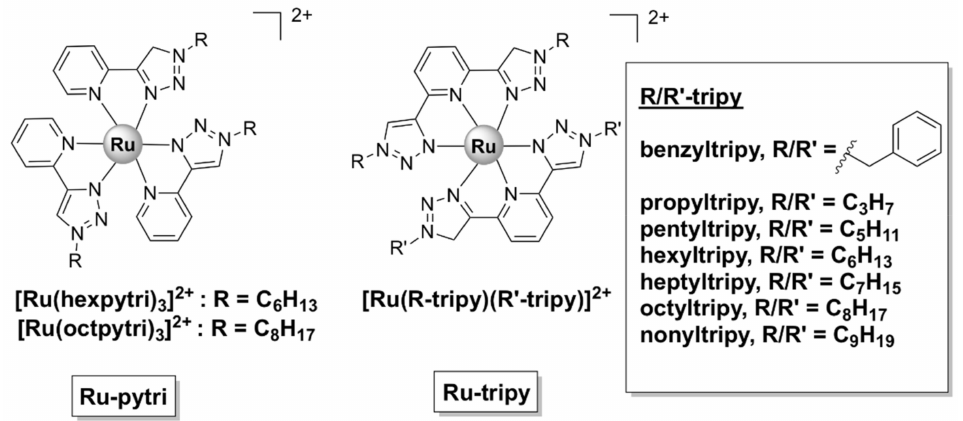
Figure 12. Chemical structures of ruthenium(II) complexes with “click” pyridyl-1,2,3-triazole lig- ands with various aliphatic and aromatic substituents (generally denoted as Ru-pytri [53] and Ru-tripy [54]). Adapted with permission from [53], Copyright © 2016, American Chemical Society and [54], © 2019 Wiley-VCH Verlag GmbH & Co. KGaA,